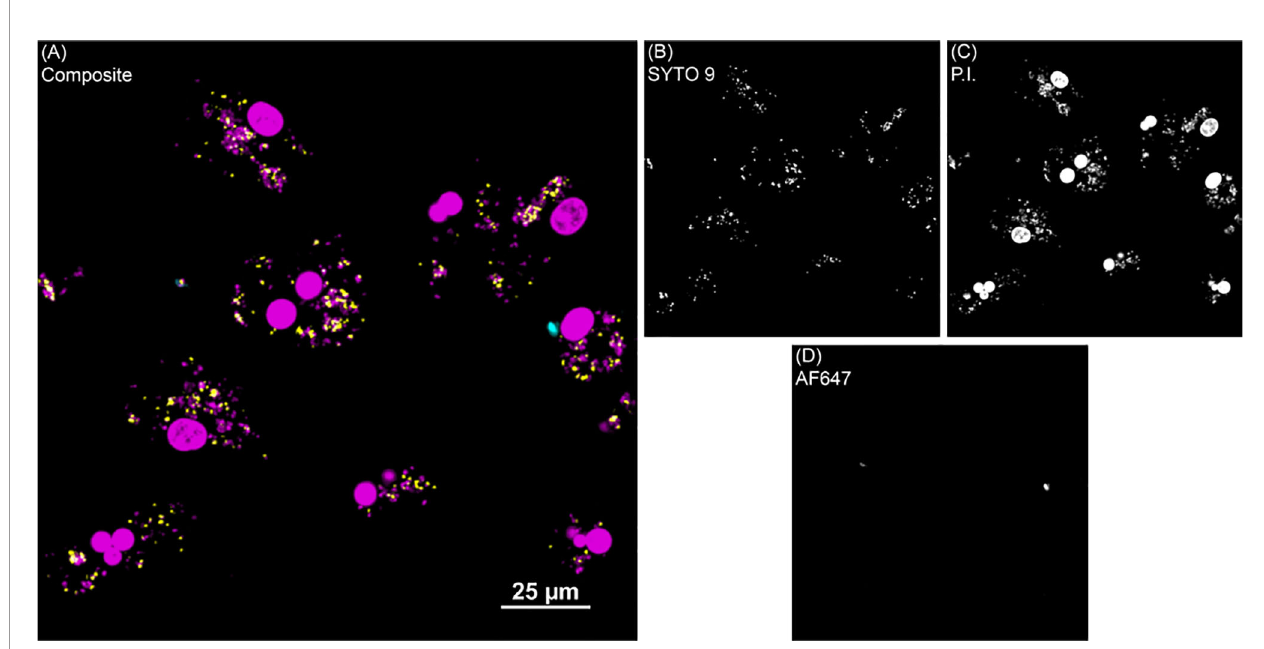
FIGURE 2 | Bac Light fl uorescence to investigate intracellular MAP viability. (A) Shows one representative image of monocyte derived macrophage culture without vitamin D 3 treatment from a clinical cow. (B) SYTO 9 (yellow) represents viable intracellular MAP detected in the 488 nm channel. (C) Propidium iodide (P.I.) was used to label intracellular nonviable MAP in the 561 nm channel (magenta). Large, dense magenta spheres are nuclei and were excluded from analysis based on size. (D) Extracellular MAP (cyan) that was not washed away was detected in the 640 nm channel, and its dual labeling with P.I. or SYTO 9 fl agged those bacteria for exclusion from